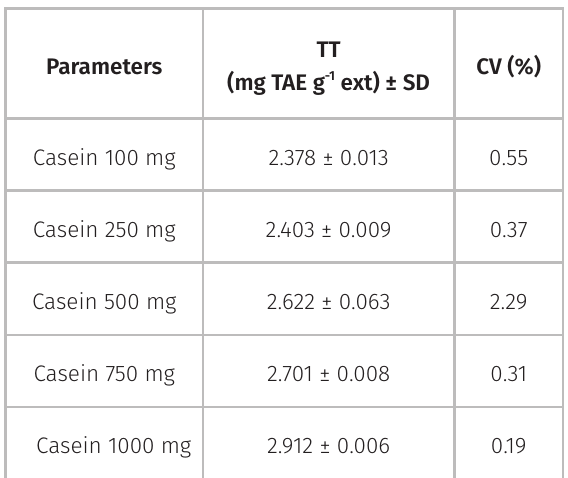
Table I. TT quantification according to increase mass of